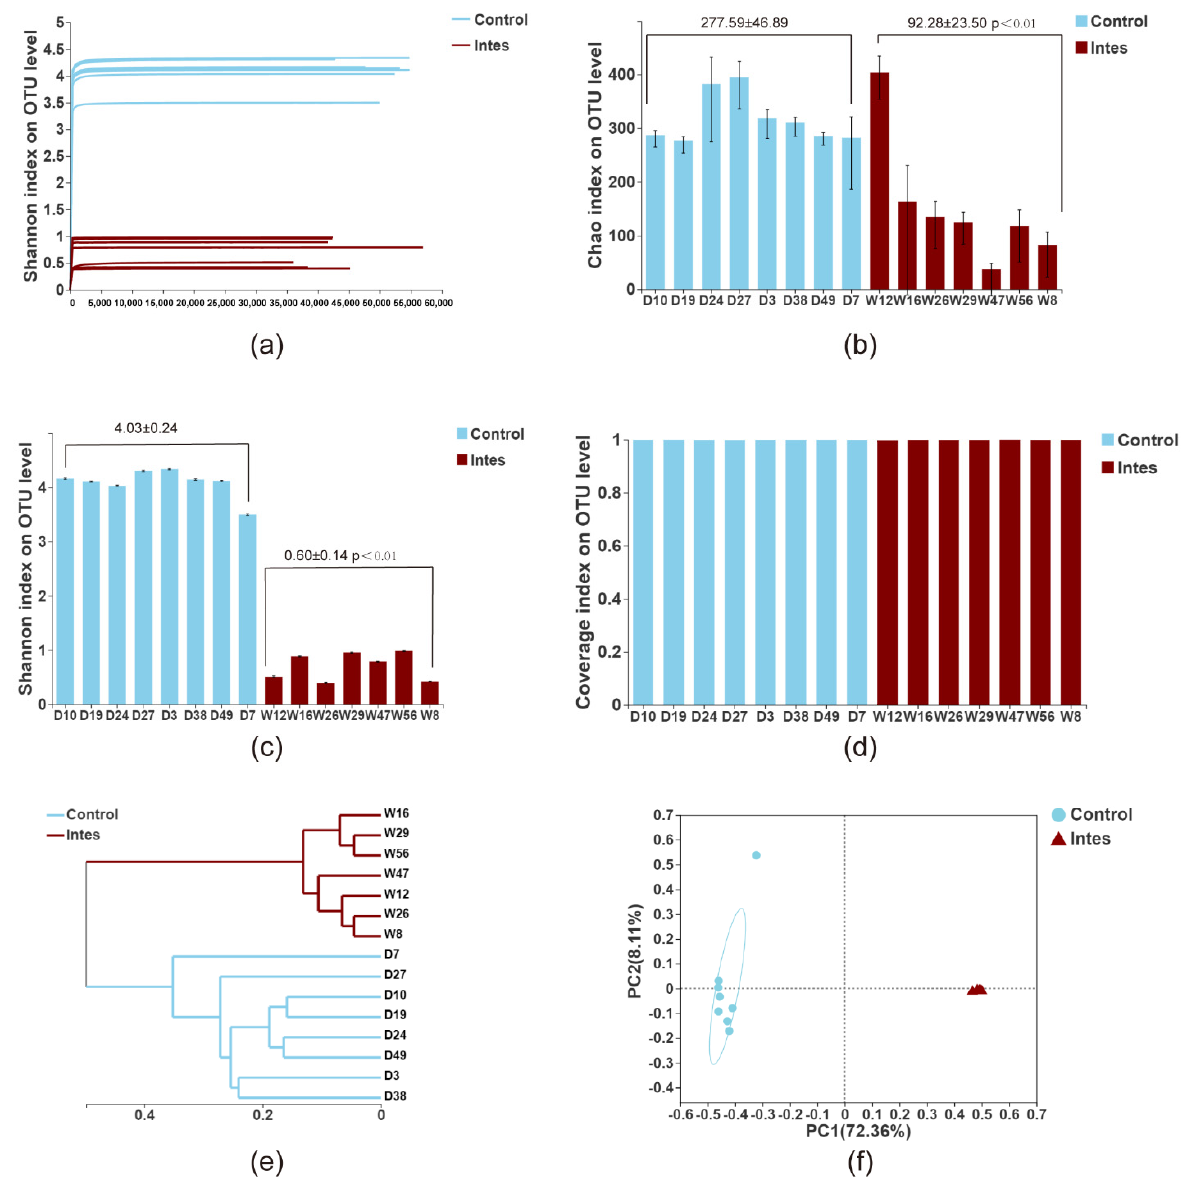
Figure 2. Analysis of α and β diversity of intestinal flora ( a ). Shannon-Wiener diversity curve ( b ). Chao index ( c ). Shannon index ( d ). Coverage index ( e ). Sample hierarchical clustering ( f ). PCoA. p < 0.01 as compared to the Ctrl group.